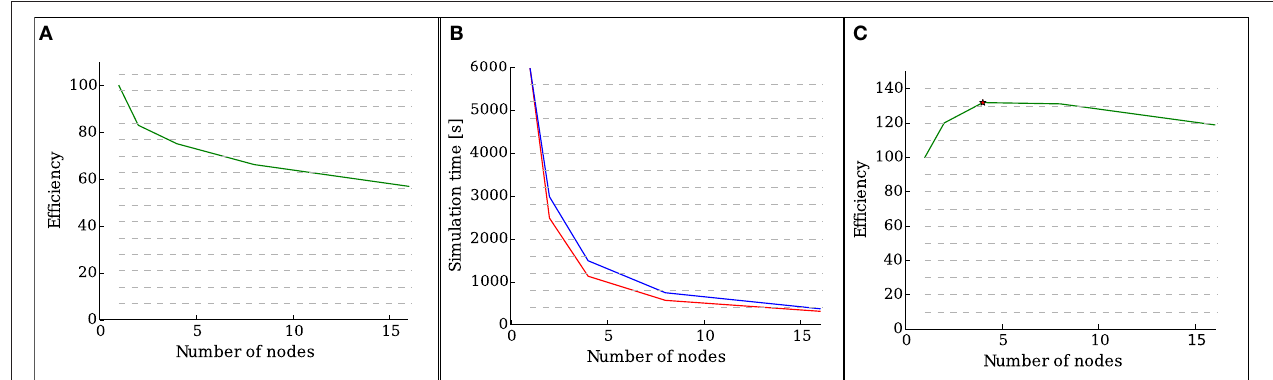
Frontiers in Neuroanatomy |